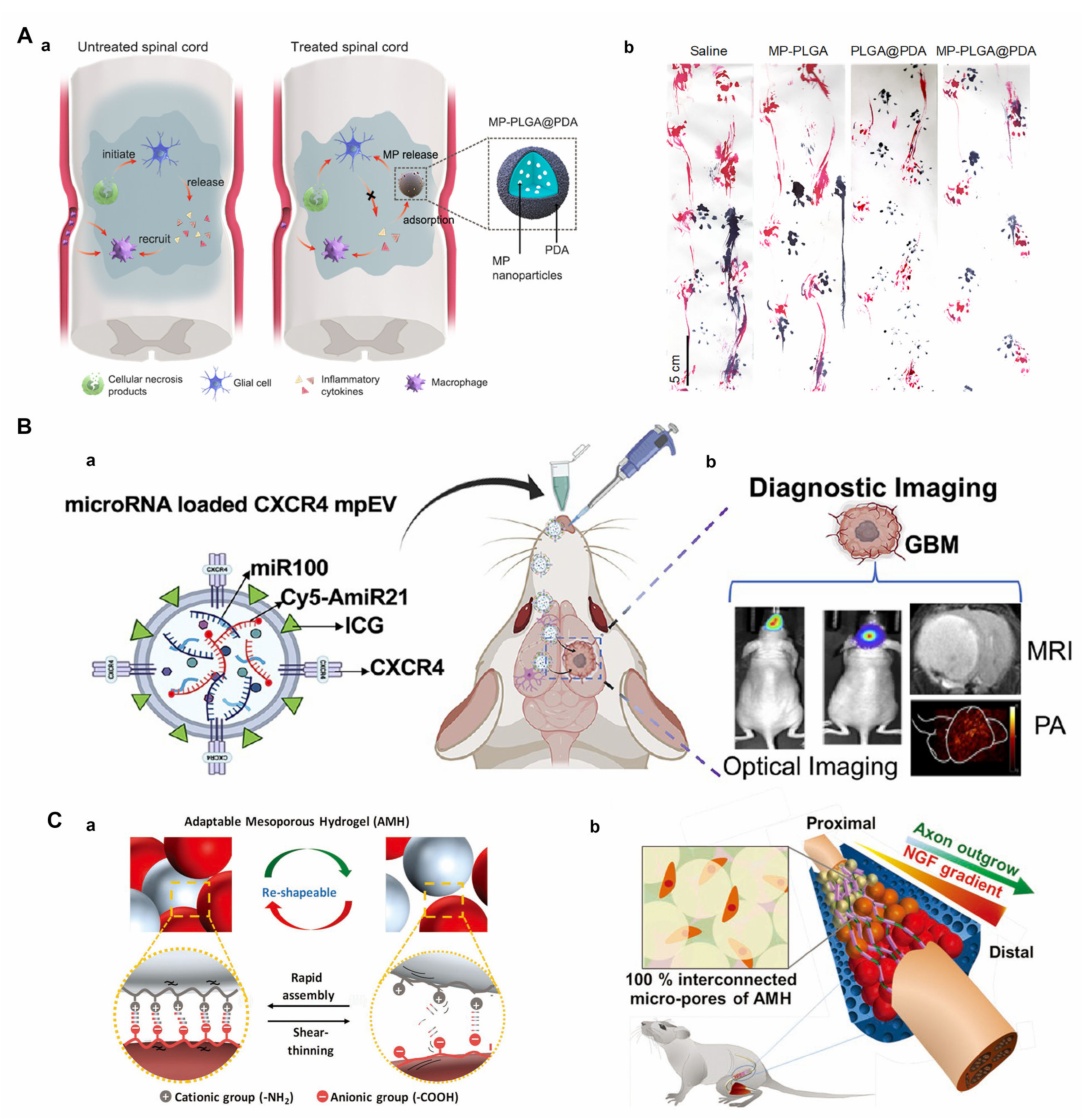
Figure 6. ( A ) Two-pronged cytokine suppressive strategy for promoting the functional recovery of the injured spinal cord by capturing the released cytokines and inhibiting the secretion of new ones ( a ). Representative footprint images of rats for assessing the recovery of motor function at day 28 post-injury ( b ). ( B ) Schematic of the intranasal administration of mpEVs in mice bearing orthotopic glioblastomas (GBMs) ( a ). The delivered mpEVs monitored using optical imaging, MRI, and pho- toacoustic imaging ( b ). ( C ) A sTable 3D scaffold formed by mixing oppositely charged building blocks via interaction ( a ). Schematic of adaptable microporous hydrogel (AMH) with the gradient propagation of NGF for directed and accelerated axonal regeneration in vivo ( b ). ( A ) Adapted with permission from Ref. [100]. Copyright 2021, American Chemical Society; ( B ) Adapted with permis- sion from Ref. [101]. Copyright 2021, American Chemical Society; ( C ) Adapted with permission from Ref. [102]. Copyright 2019, WILEY-VCH Verlag GmbH & Co. KGaA,